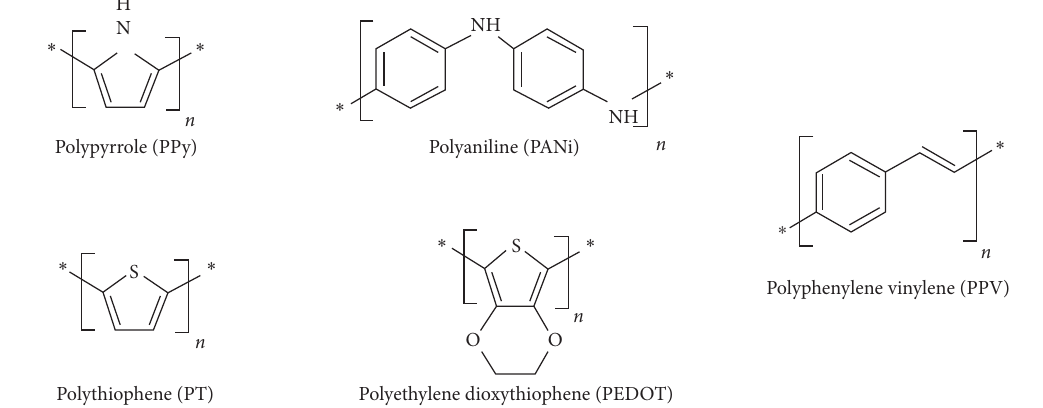
Figure 1: Chemical structures of various conductive polymers [12].